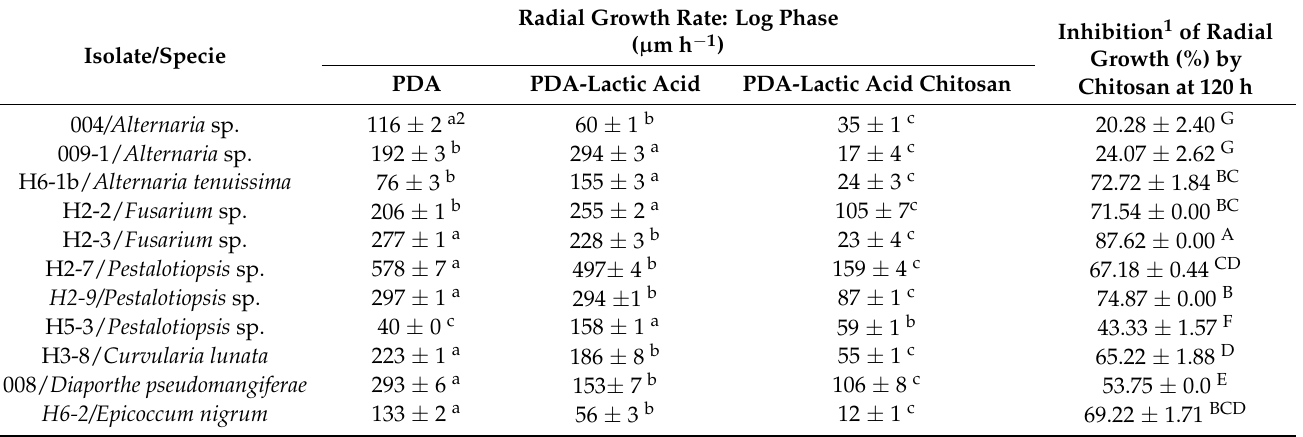
Table 3. Chitosan sensitivity of other fungi species isolated from anthracnose on mango. Radial growth in medium PDA, PDA-lactic acid (0.05 M), and PDA-lactic acid (0.05 M) with 1 g L − 1 chitosan at 25 ◦